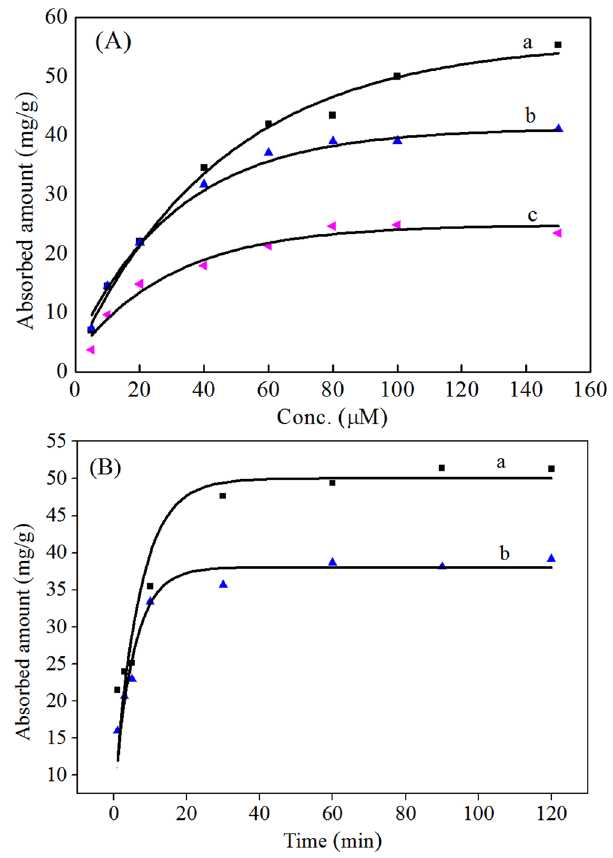
Figure 3. ( A ) The adsorption isotherms of SAR on the PDA@GO/Fe 3 O 4 (a), NPDA@GO/Fe 3 O 4 (b), and GO/ Fe 3 O 4 (c) nanoparticles. Symbols: experimental data; lines: Langmuir model predictions. ( B ) The sorption kinetics of SAR on the PDA@GO/Fe 3 O 4 (a) and NPDA@GO/Fe 3 O 4 (b) nanoparticles. Symbols: experimental data; lines: pseudo second order kinetic model